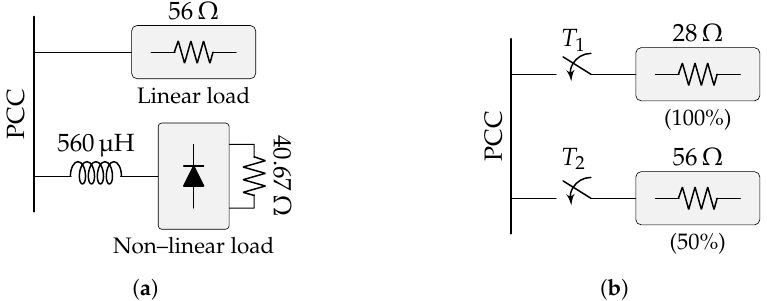
Figure 12. Setup for experimental results: ( a )Steady state results with non-linear loads; ( b )Linear load step variation.